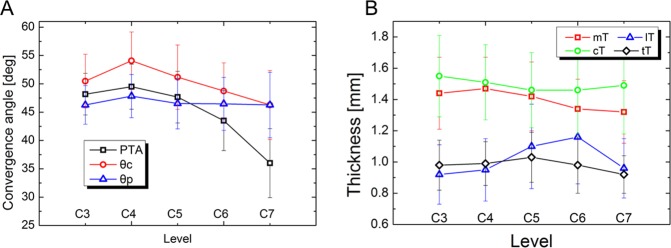
(A) PTA, θp, and θc had similar patterns except at C7. The angle difference was within 5° at C3–6. (B) mT/cT was significantly thicker than lT/tT at all levels. cT thickness remained constant thickness regardless of vertebral level.